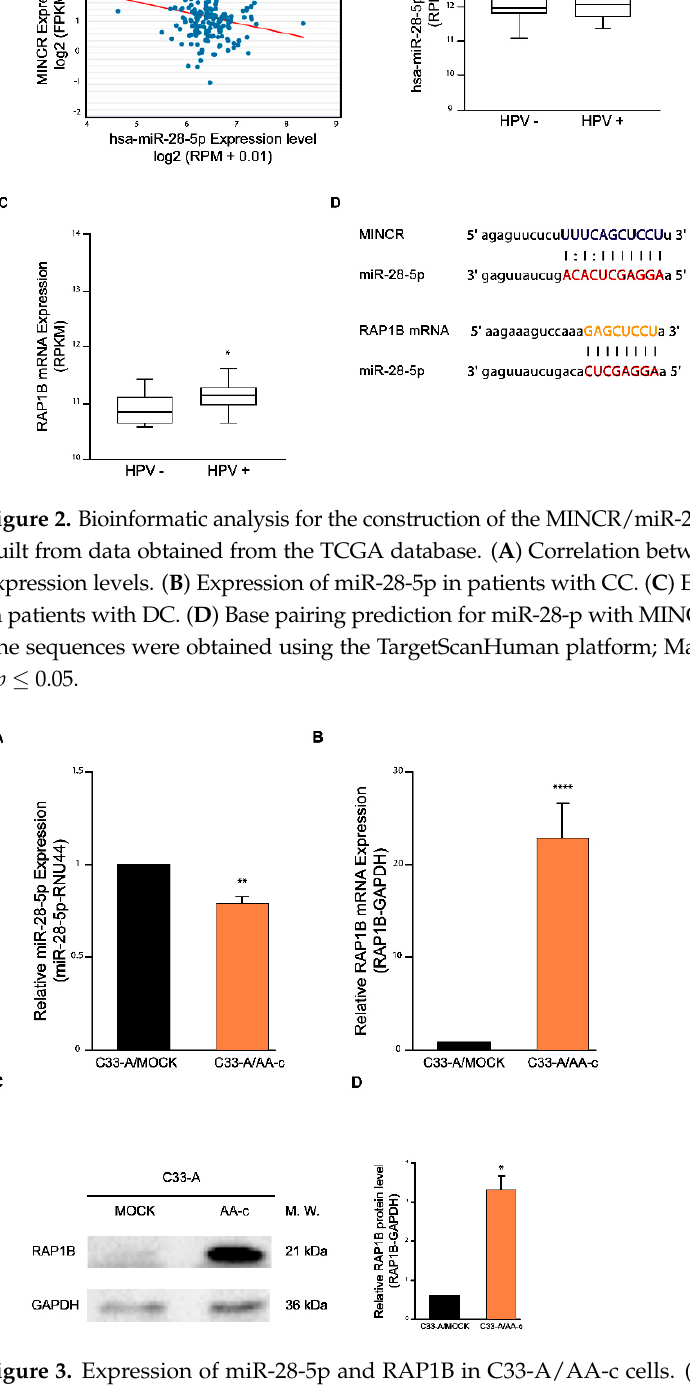
Figure 3. Expression of miR ‐ 28 ‐ 5p and RAP1B in C33 ‐ A/AA ‐ c cells. ( A , B ) RT ‐ qPCR was used to measure the level of miR-28-5p and RAP1B mRNA in C33-A/AA-c cells compared to control cells. The relative expression was normalized with the small nucleolar RNA RNU44 and GAPDH, respectively. ( C ) RAP1B protein level measured by Western blot. The relative levels of RAP1B obtained with respect to GAPDH protein levels were used as an endogenous control. ( D ) Densitometry analysis is shown. Student’s t -test * p ≤ 0.05, ** p < 0.01, **** p < 0.0001.